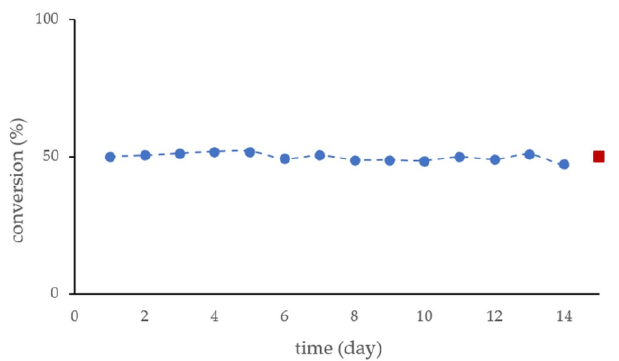
Figure 6. Long-term operational stability of the KR of racemic 4-(morpholin-4-yl)butan-2-ol (±)- 1 within the preconditioned U-shape CaLB-MNP C15 reactor. The blue dots represent the conversion (50 ± 0.9%) in a sample at each day of a two weeks long run at room temperature (25 °C), while the red square shows the average. In each sample, the ee of products (( R )- 2 and ( S )- 1 ) exceeded 98%. During the long term run of the U-shape CaLB-MNP C15 reactor, 20 mL reaction mixture was collected. The average and standard error data ( c = 49.8 ± 1.33) for the samples during the steady state of the long-term run (Figure 6) were in good agreement with the conversion value ( c = 49.8%) determined for the collected total outflow solution. The products isolated from this mixture (( R )- 2 : Y = 48.0%, [ α ] 25 D = +1.2; ( S )- 1 : Y = 40.5%, [ α ] 25 D = +3.2; ee >